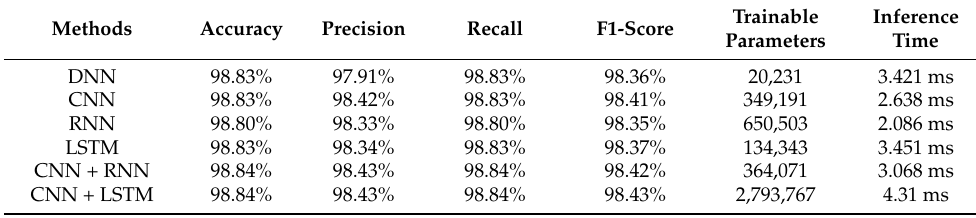
Table 27. Comparison results of multi-class